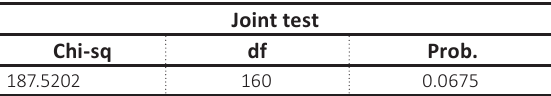
Table 7. VAR residual heteroskedasticity tests